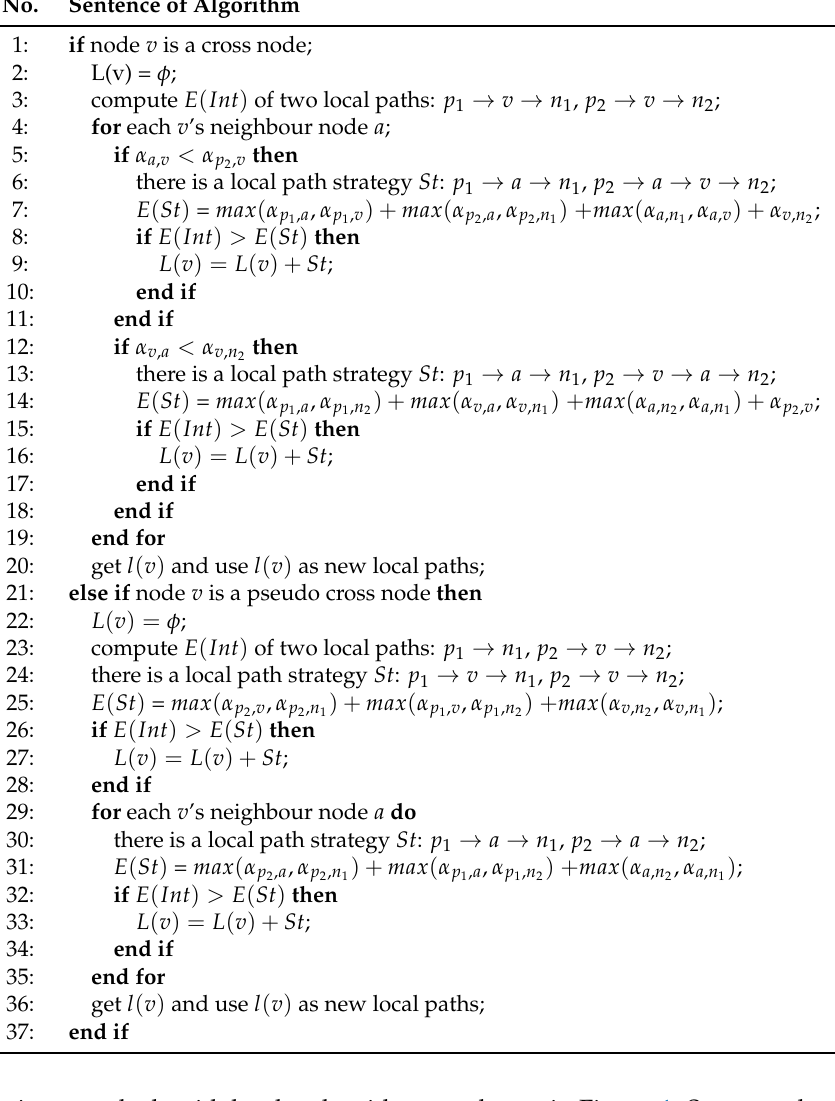
Table 1. Main part of optimal local path